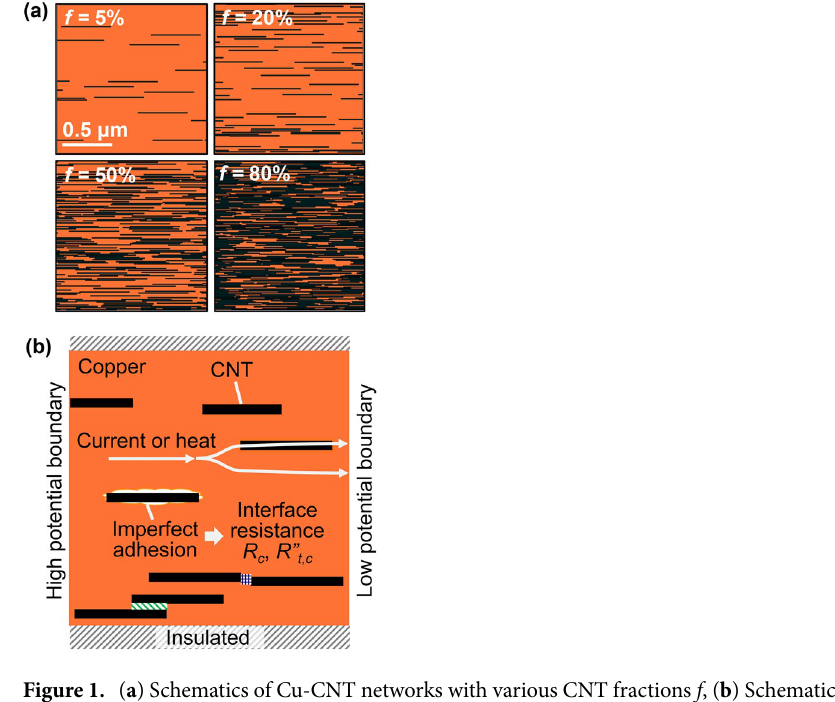
Figure 1. ( a ) Schematics of Cu-CNT networks with various CNT fractions f , ( b ) Schematic of a Cu-CNT network with boundary conditions. The patterned bars represent the side-to-side and end-to-end CNT-CNT interfacial